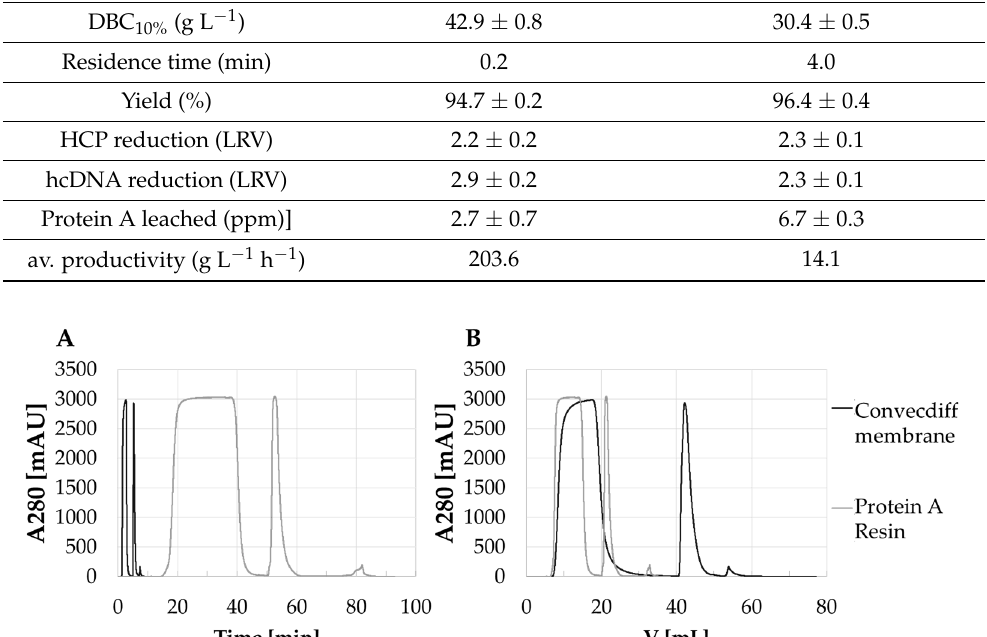
Table 6. CPP and CQA of mAb 1 purified with convecdiff membrane and standard resin.